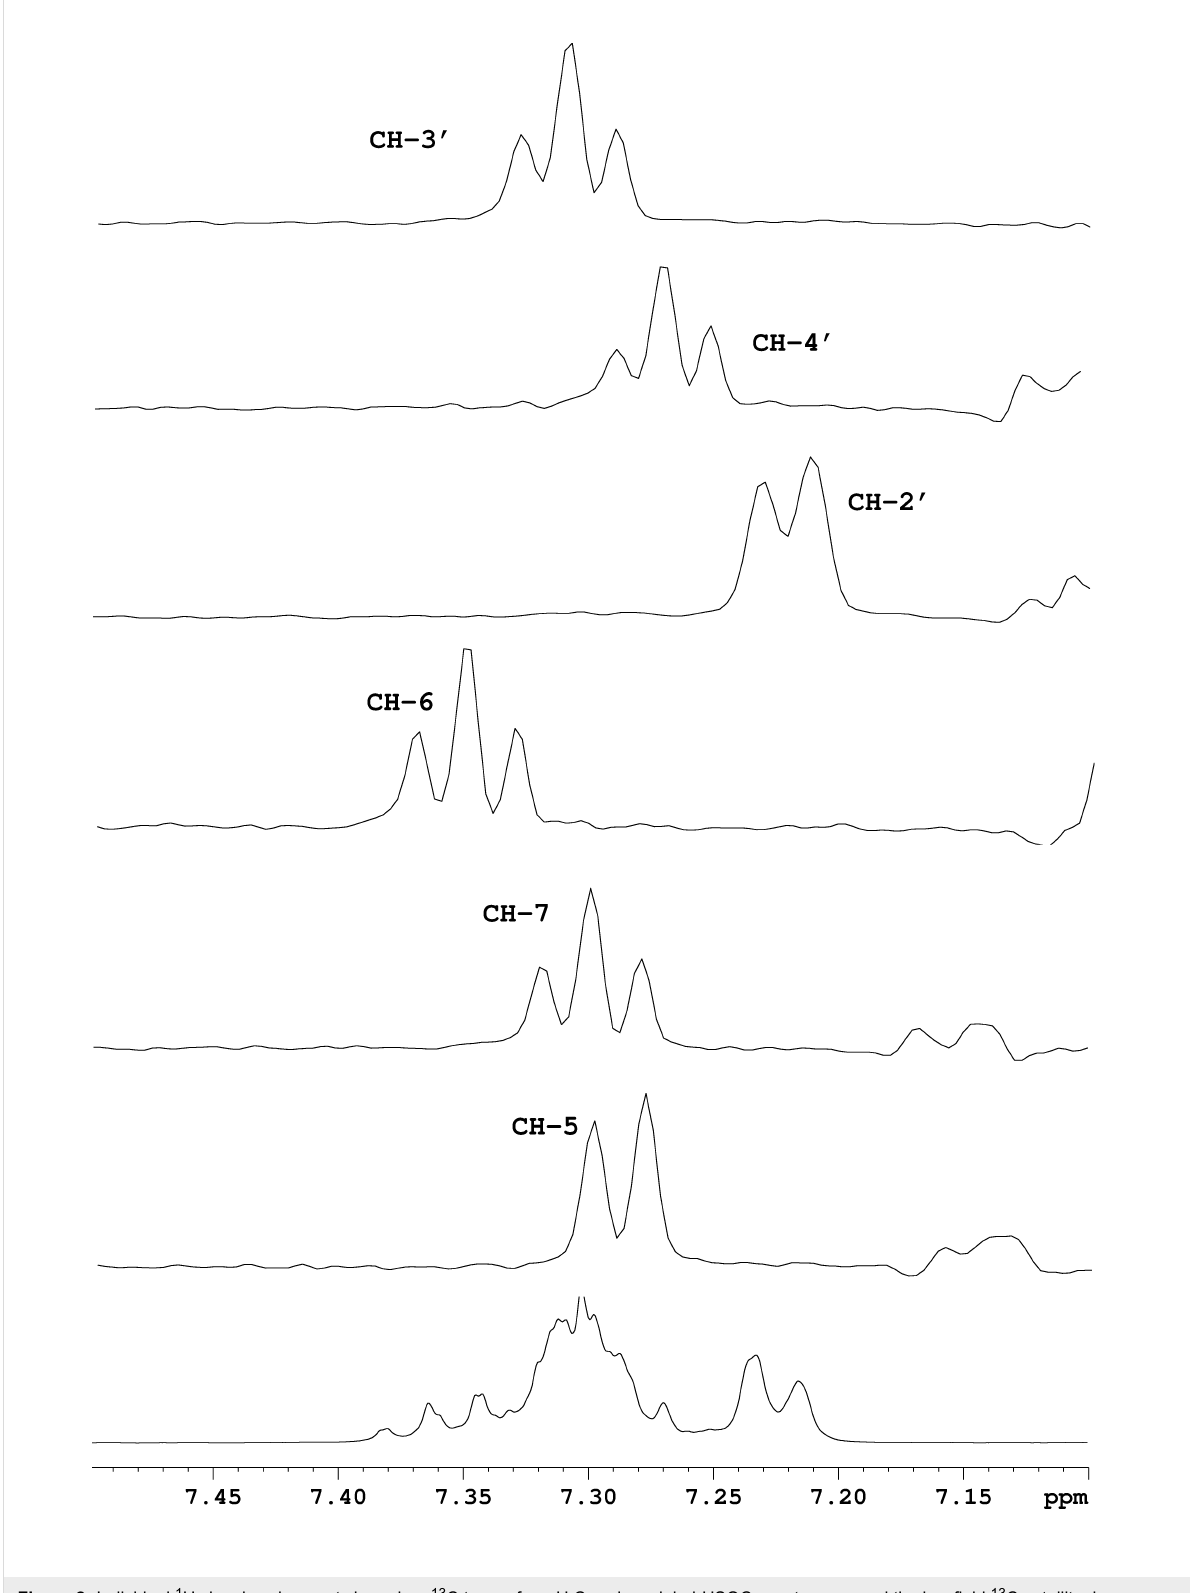
Figure 2: Individual 1 H signal assignments based on 13 C traces from H,C-undecoulpled-HSQC spectrum around the low field 13 C satellite, in com- parison with the 1 H NMR spectrum (bottom) for compound 5h